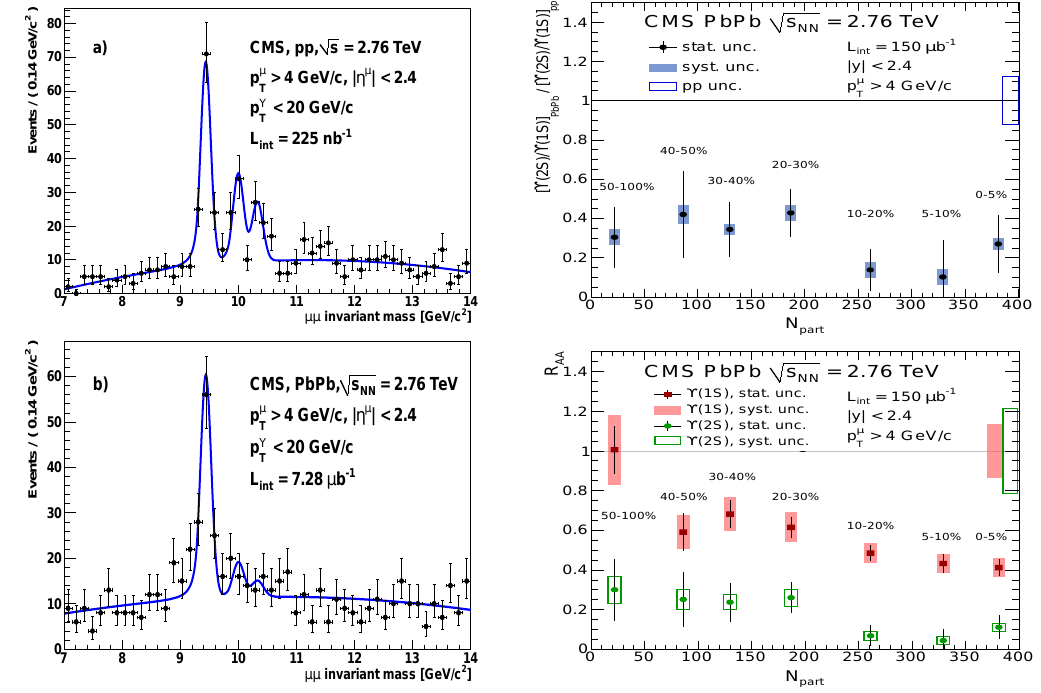
Figure 25. Left : The di-muon invariant-mass distributions from the ( a ) p + p and ( b ) Pb + Pb data √ s at = 2.76 TeV; Right : The centrality dependence ( top ) of the double ratio and ( bottom ) of the NN nuclear modification factors R AA for the Υ (1S) and Υ (2S) states. The event centrality bins are indicated by percentage intervals. Reproduced from Ref.